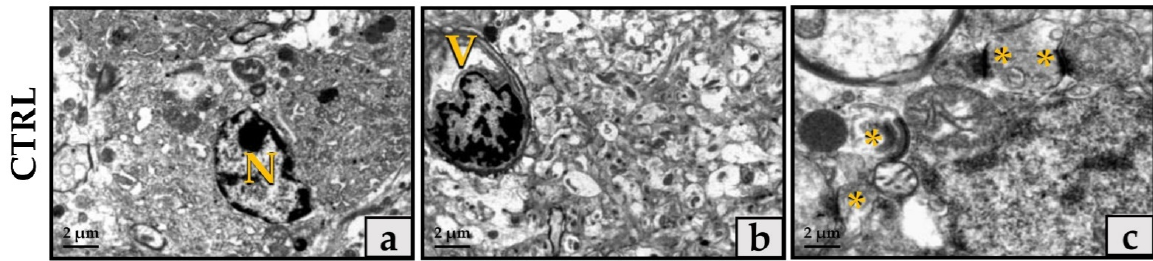
Figure 2. Ultrastructural evaluation by transmission electron microscopy (TEM) of the hippocampus of sedentary mice. ( a ) TEM evaluation of the hippocampus of CTRL mice not subjected to continuous aerobic training showed normal tissue organization with well-preserved nerve and glial cells. ( b ) Nerve processes were well represented, rich in neurotubules and neurofilaments, with slight vacuolization at the axonal level. ( c ) Synapses were well represented with well-preserved morphology. Scale bar represents 2 μ m (N: nucleus; V: vessel; *: synapse).